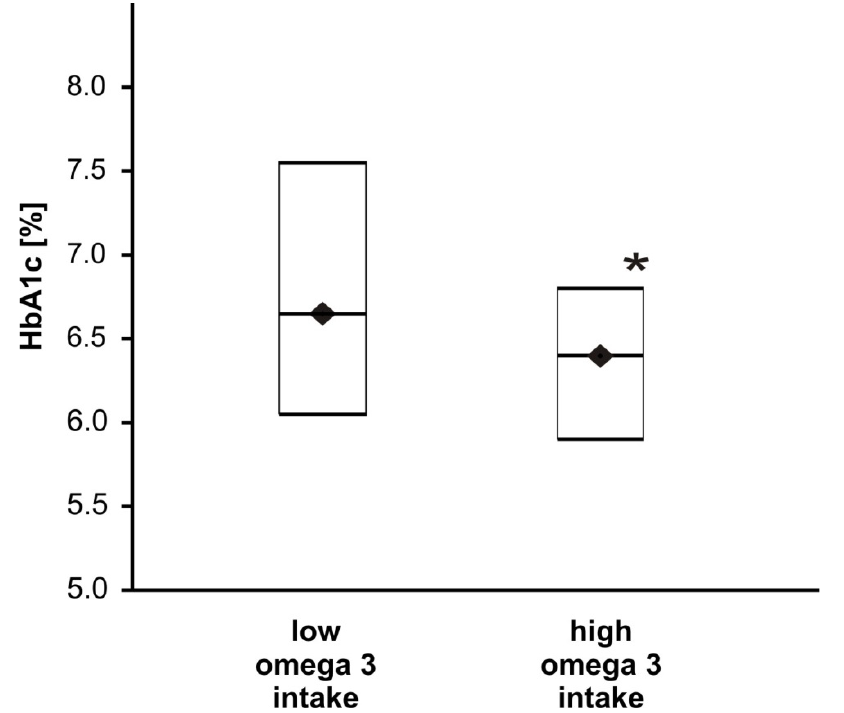
Figure 2. The effect of omega 3 intake on the HbA1c fraction in T2DM patients. Data are shown as medians and interquartile ranges (Q1; Q3). The HbA1c fraction was significantly lower for the group with high omega 3 intake ( n = 65) compared to the group characterised by low omega 3 intake ( n = 64), * p < 0.05.